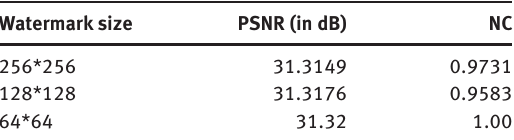
Table 4: PSNR and NC Performance for Different Size of Watermark.